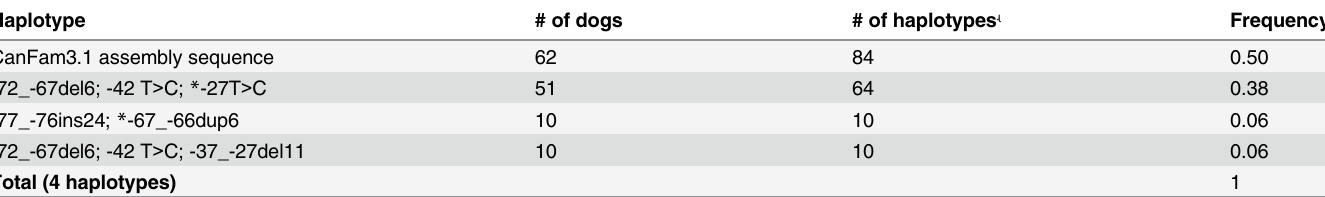
Table 2. 5 ’ UTR Cox-2 variants found in 84 Flat-Coated Retrievers.